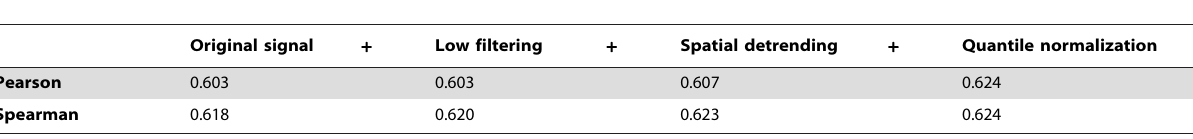
Table 1. Effect of preprocessing steps on prediction